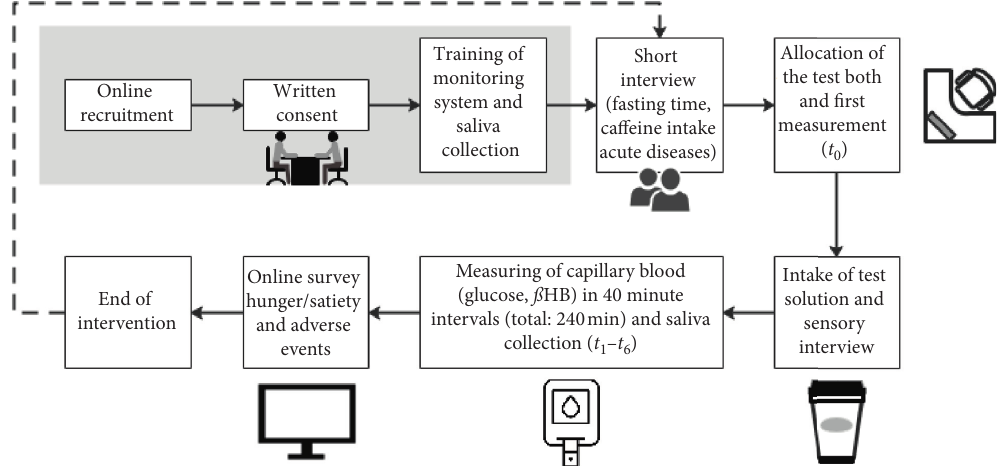
Figure 1: A schematic of the study